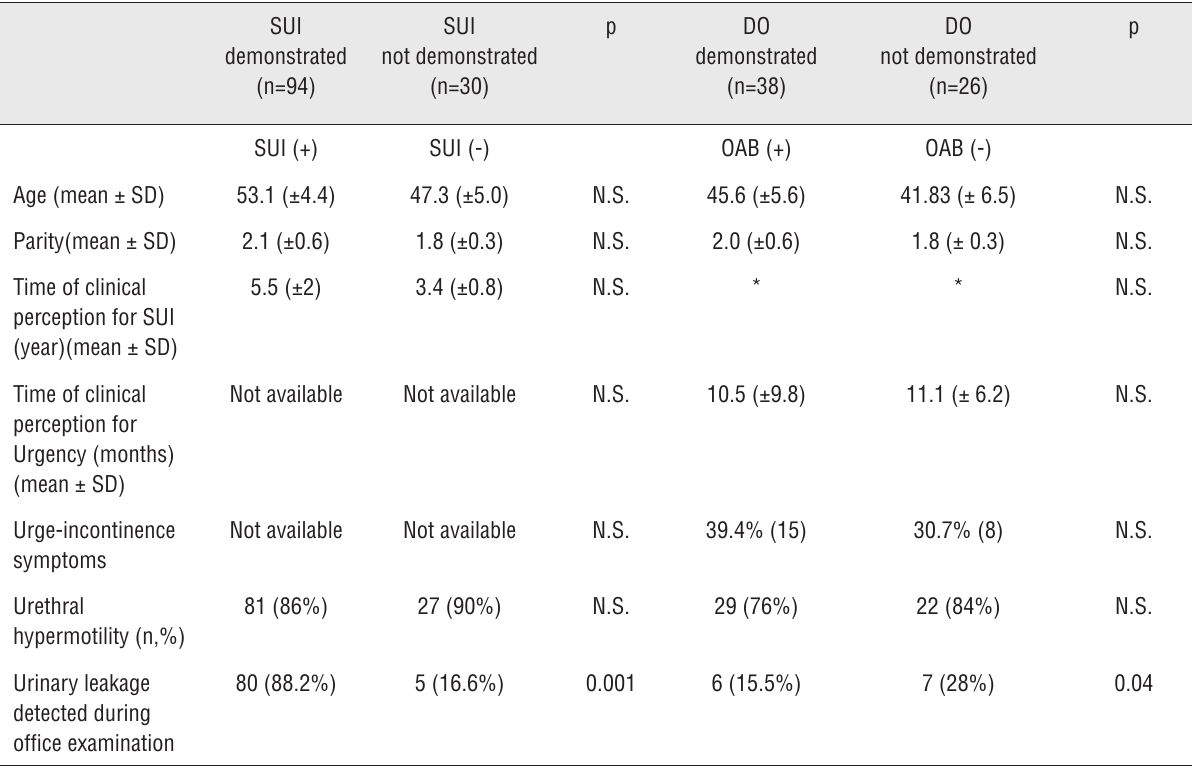
Table 1 - Characteristics of 2 arm groups of women operated for SUI or treated with anticholinergic